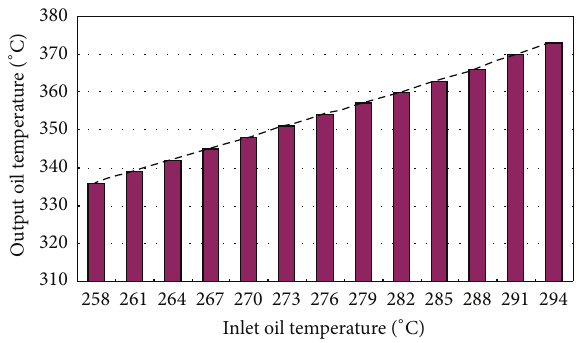
Figure 8: The relation between output oil temperature and oil inlet temperature alterations.